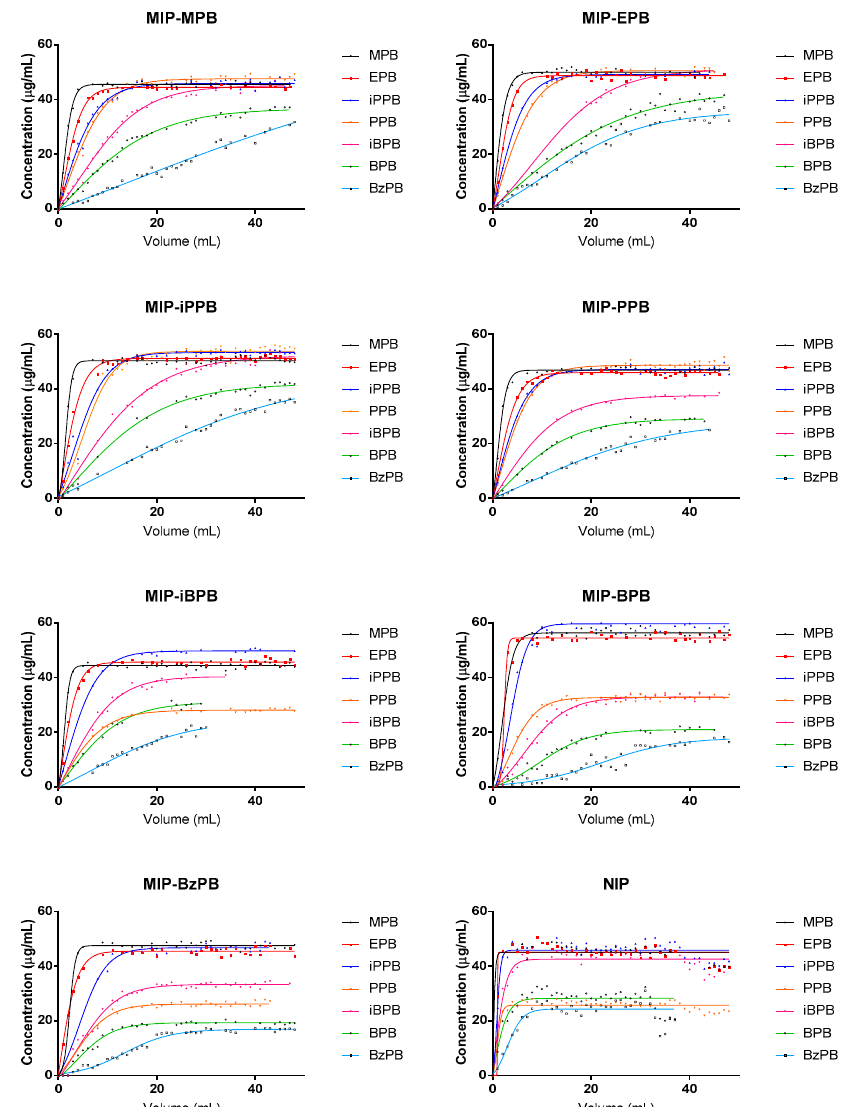
Figure 2. Boltzmann’s functions determined for parabens on the different MIPs sorbent.